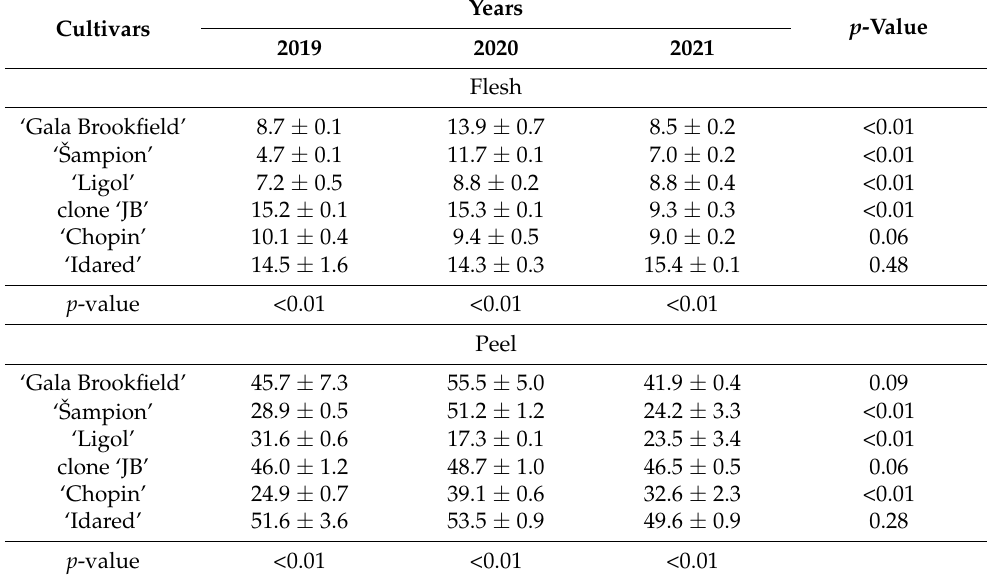
Table 8. The values of phenolic acids content (mg · 100 g − 1 FW) for flesh and peel of apples depending on cultivars and years of